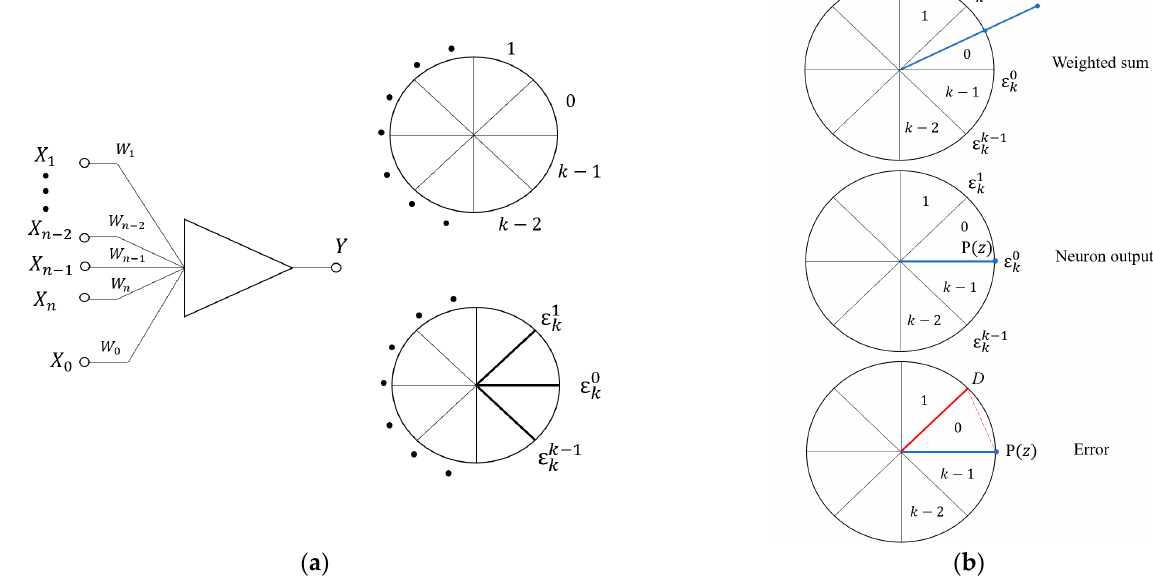
Figure 6. Graphical representation of the complex neuron and its response: ( a ) Division of the complex plane caused by the neuron; ( b ) Representation of the weighted sum, neuron output and neuron error over the complex plane.